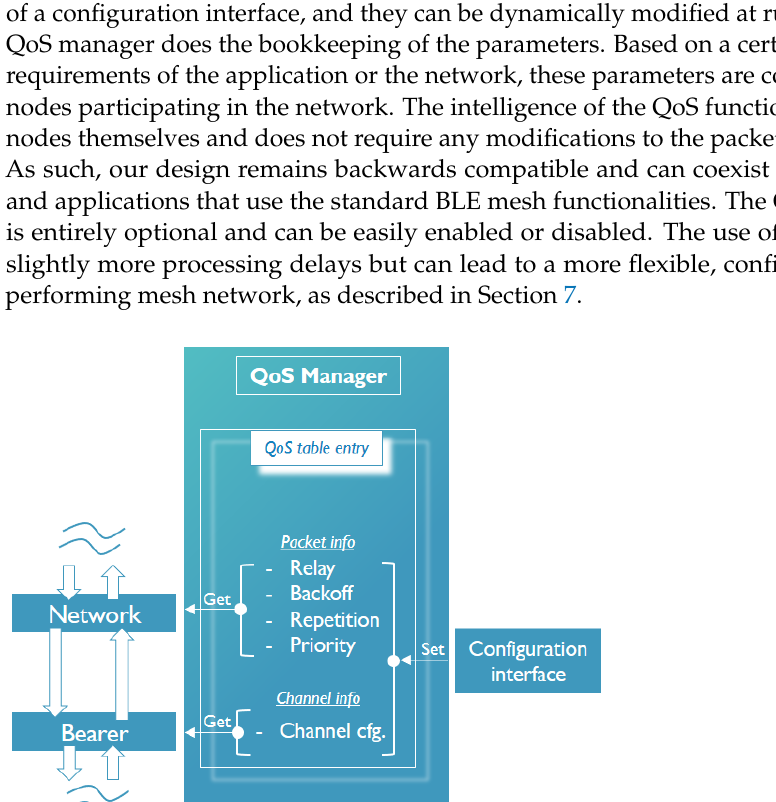
Figure 8. QoS table entry